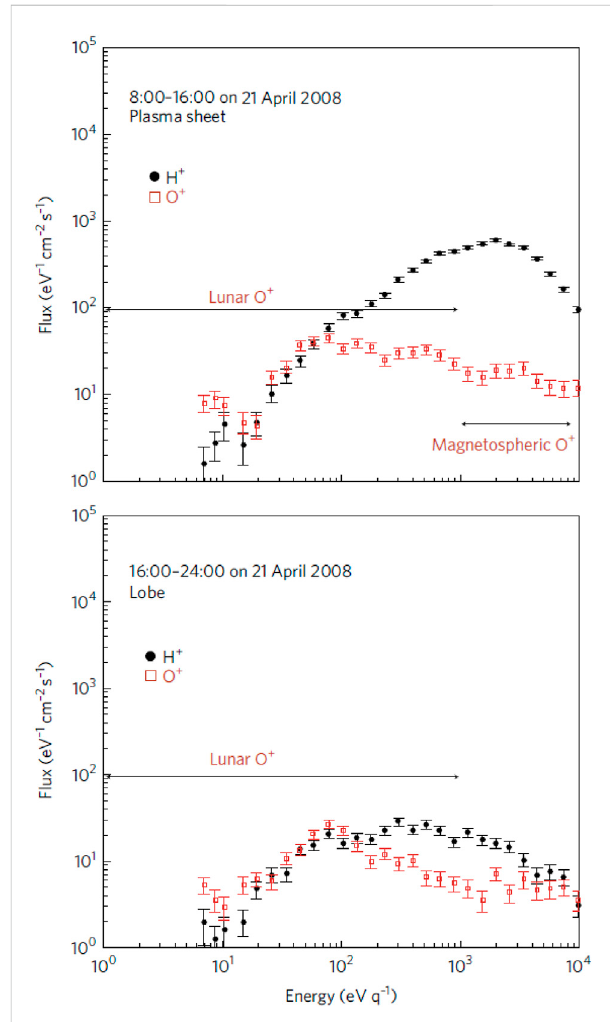
FIGURE 7 Energy distributions of H + and O + ions measured by the IMA sensor onboard the Kaguya lunar orbiter in the terrestrial magnetotail. During the plasma sheet encounter (top panel) there is an enhancement of high-energy (1 – 10 keV) O + ions, in comparison to those measured in the magnetotail lobe (bottom panel). The calculated density and net fl ux of these magnetospheric O + ions, during the plasma sheet encounter, were ×1.2 10 − 3 cm − 3 and 2.6 × 10 4 cm − 2 s − 1 respectively. (From: Terada et al.,